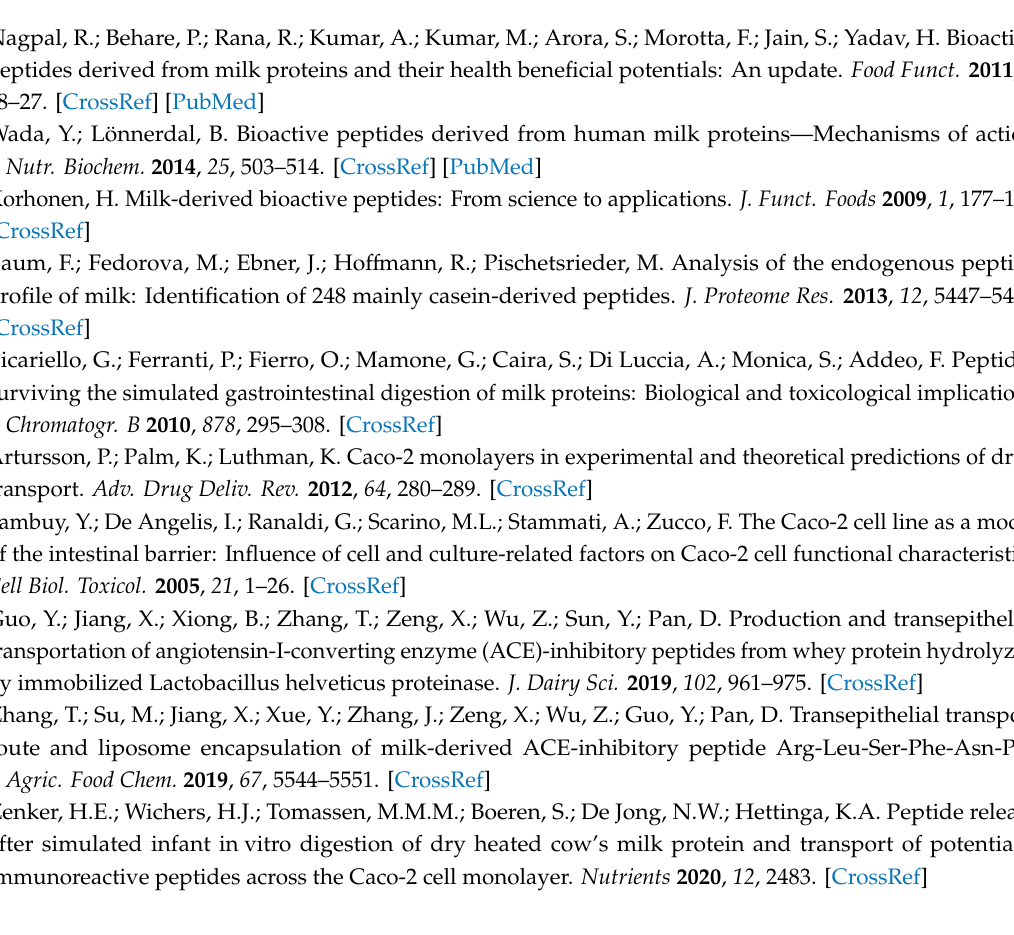
Table S1. All endogenous milk peptides identified by LC-MS / MS. Figure S1. MS / MS spectra of transported peptides from α S1 -casein transport. Figure S2. Control in vitro gastrointestinal digestion of a synthetic osteopontin peptide and milk